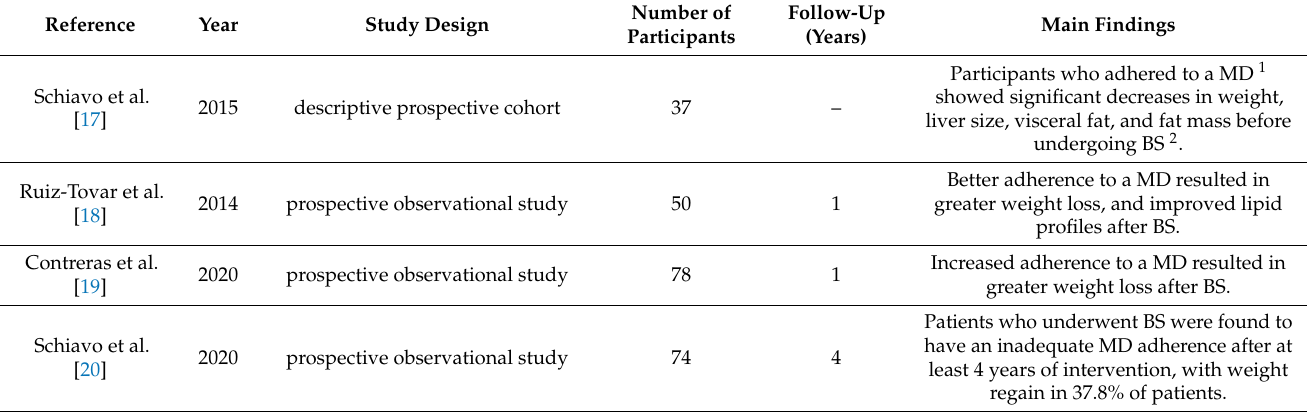
Table 1. Mediterranean Diet Adherence and Bariatric Surgery Outcome.